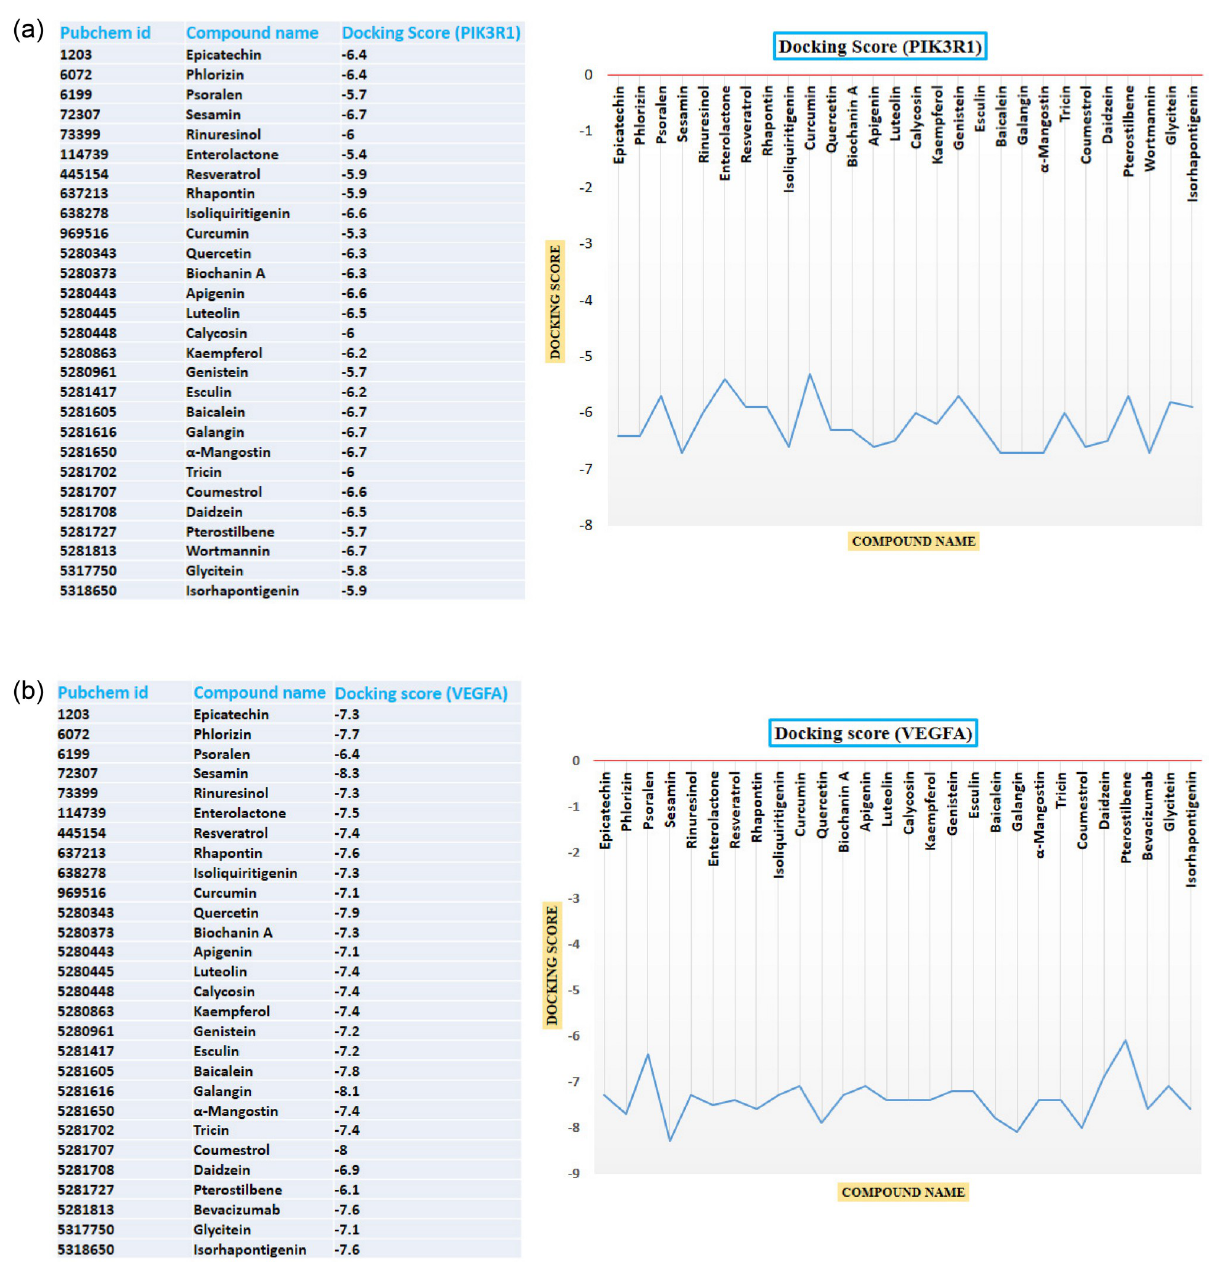
Fig 8. a : Docking scores of all compounds. Most of the compounds have a range between -5 to -7 kcal/mol binding affinities. b : Docking scores of all compounds. Most of the compounds have a range between -5 to -8.3 kcal/mol binding